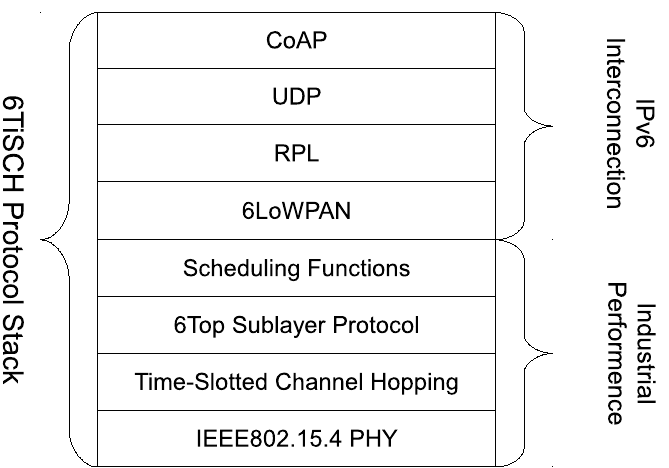
Figure 2. The 6TiSCH stack. The upper stack provides IPv6 connectivity. The lower stack, through IEEE802.15.4 TSCH, provides industrial-level